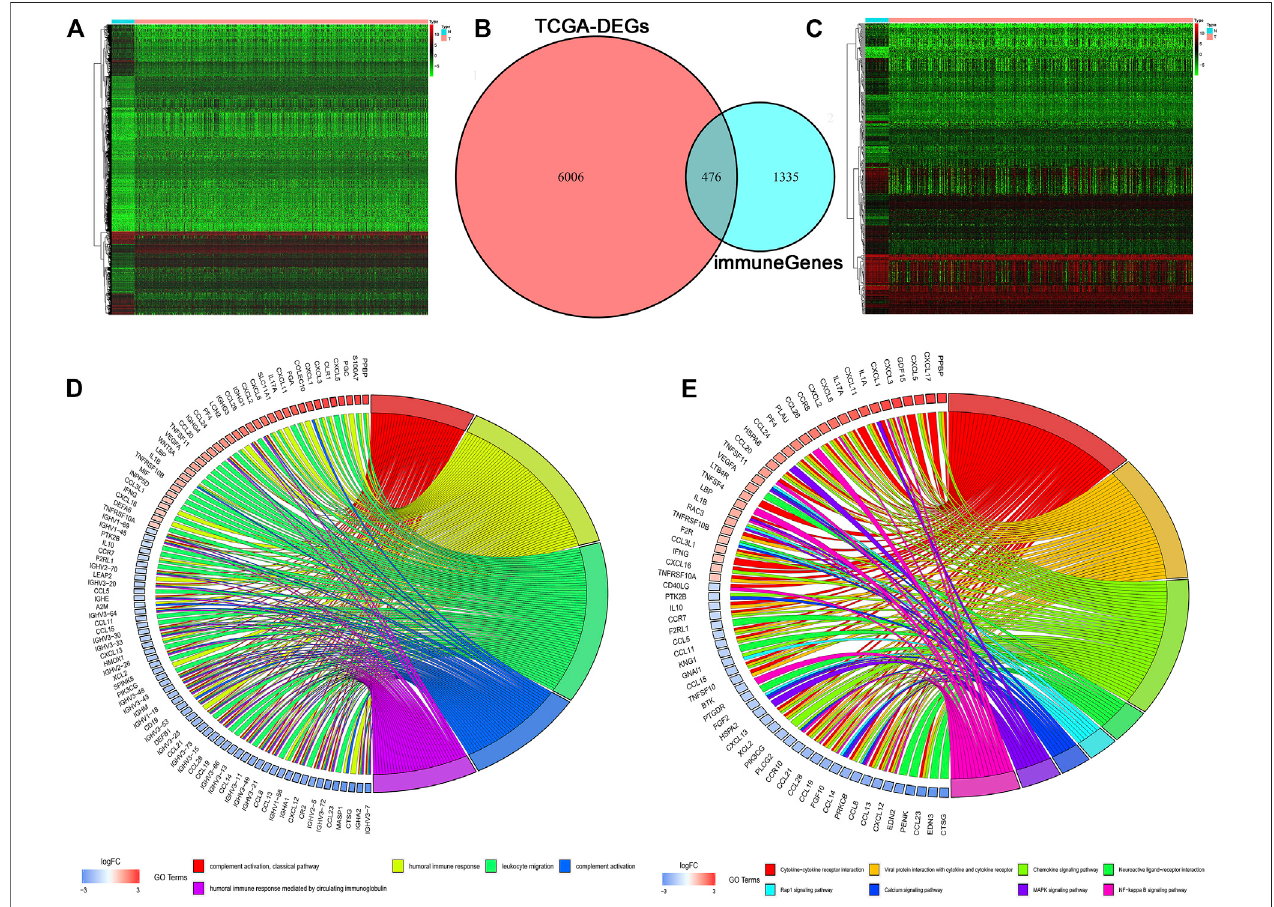
FIGURE1| Identi fi cationofdifferentiallyexpressedIRGs. (A) TheheatmapofdifferentiallyexpressedgenesinTCGA. (B) Theintersectionofdifferentiallyexpressed genes and IRGs. (C) The heatmap of differentially expressed IRGs. (D, E) GO and KEGG enrichment analyses of differentially expressed IRGs.